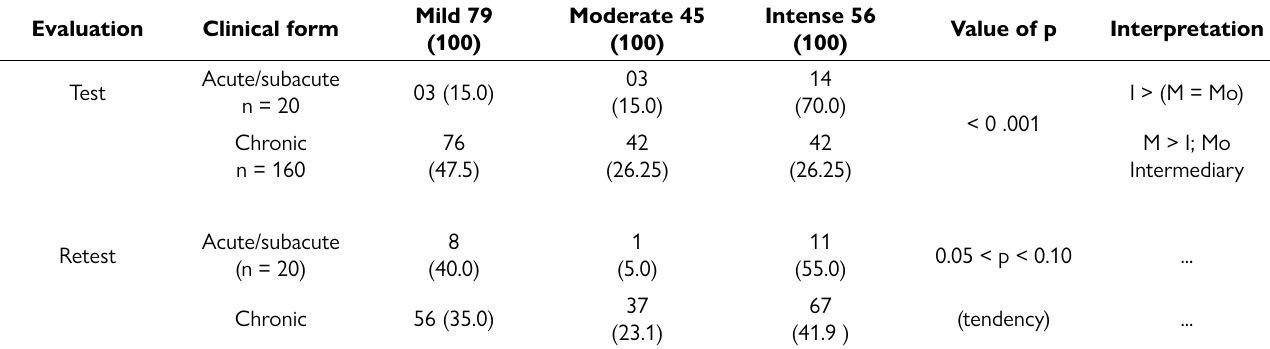
Table 3. Distribution of 20 patients with the acute/subacute form and 160 with the chronic form of paracoccidioidomycosis as to the intensity of the specific antibody serum levels, determined by the double agar gel immunodiffusion test, clinical form and moment of the serological evaluation – at admission (test) and after at least six months of storage at –80 o C